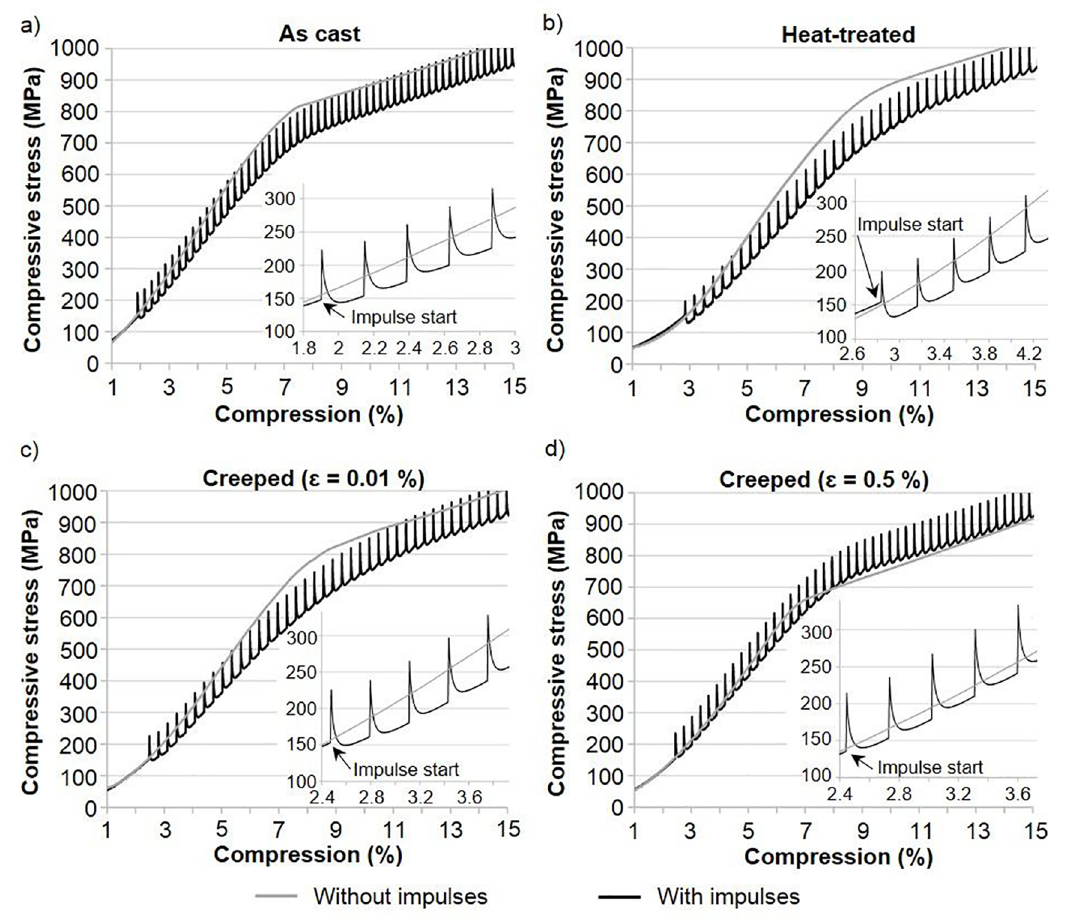
Figure 4. Stress-strain curves determined from the compression test on CMSX-4 specimens with and without superimposed electrical current-impulses (test parameters according to Table 3, test series V1 and V2) for the four material conditions a) cast, b) heat treated c) creep strain of 0.01 % and d) creep strain of 0.5